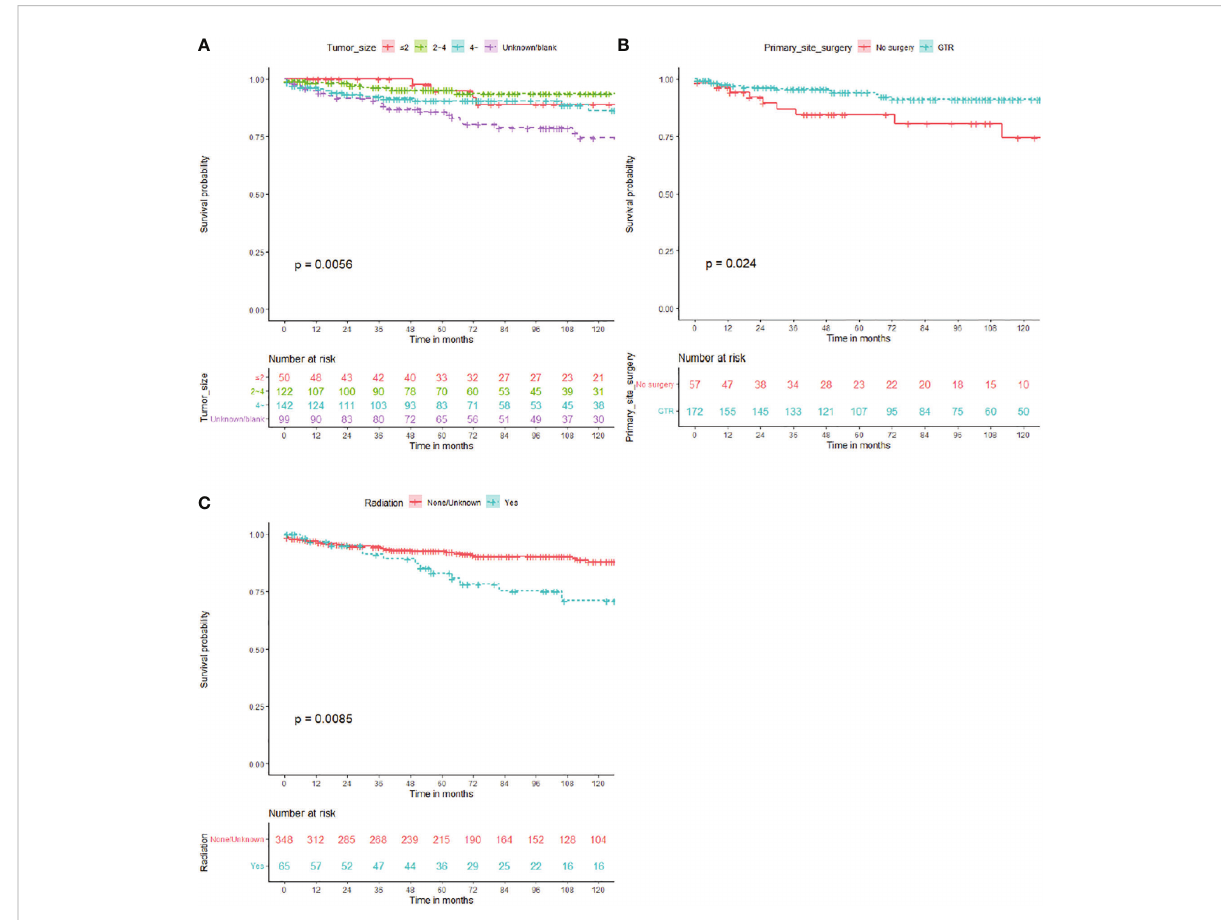
FIGURE 2 Overall survival (OS) in all patients with central neurocytoma. (A) OS among the different tumor size groups. (B) OS among the different primary site surgery (therapy) groups. (C) OS among the different radiation groups. OS, overall